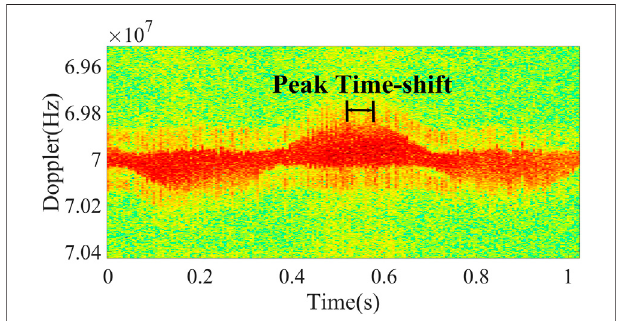
FIGURE 6 | Experimental result of the time – frequency diagram.